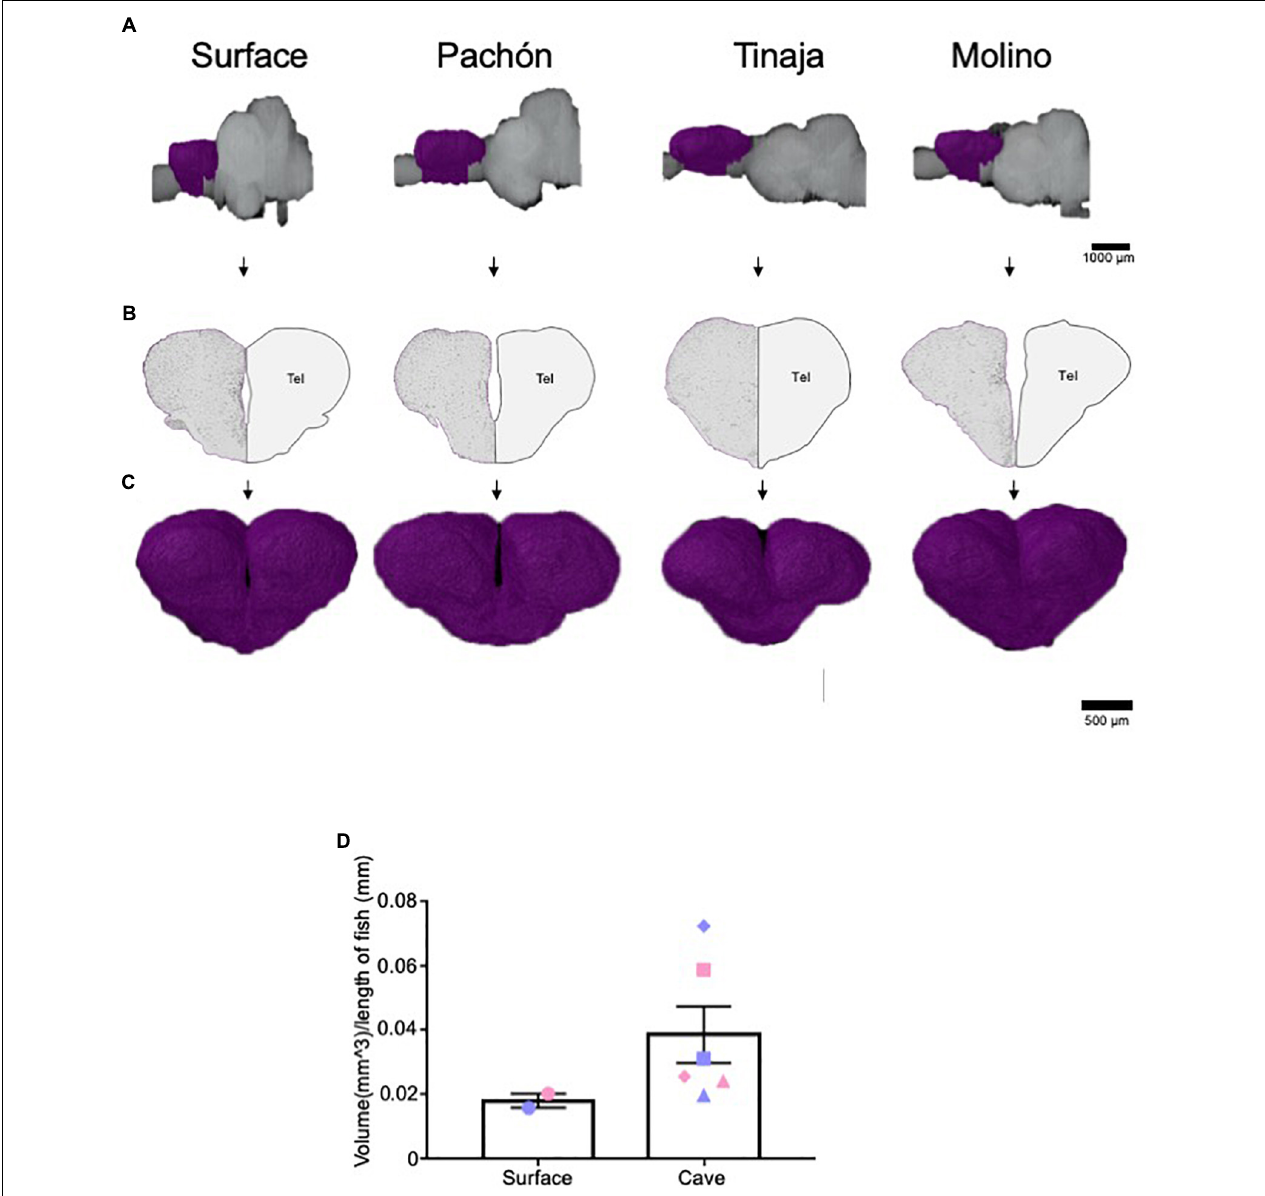
FIGURE 3 | Expansion of telencephalon in cavefish populations. (A) 3-D reconstructions of Surface, Pachón, Tinaja, and Molino with demarcated telencephalon (purple) displayed. (B) Images of demarcated sections that were Nissl stained (left) and a cartoon of demarcated region (right). (C) Close up view of the 3-D reconstruction of the telencephalon from an anterior view. (D) The telencephalon from most cave animals was larger than that of surface conspecifics (Surface fish 0.018 ± 0.0022, Cave fish 0.039 ± 0.0088 t -test t = 1.276, df = 6, p = 0.12). Graph in panel (D) is the mean ± standard error of the mean. Blue points on bar graphs denote males, whereas light red denotes female. Square points on graphs represent Pachón, triangle points on graphs represent Tinaja and diamond points on graphs represent